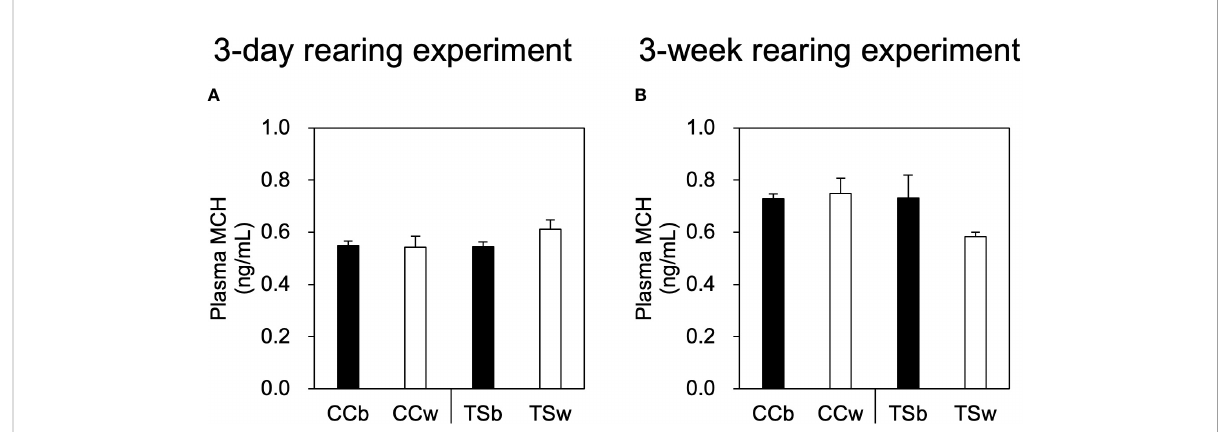
FIGURE 4 Effects of background color on plasma MCH level. Plasma MCH levels in the 3-day rearing experiment (A) and 3-week rearing experiment (B) . Data are shown as mean ± SE. No signi fi cant difference was estimated using the Welch test; n = 10 for CCb and CCw n = 5 for TSb, and n = 6 for TSw.